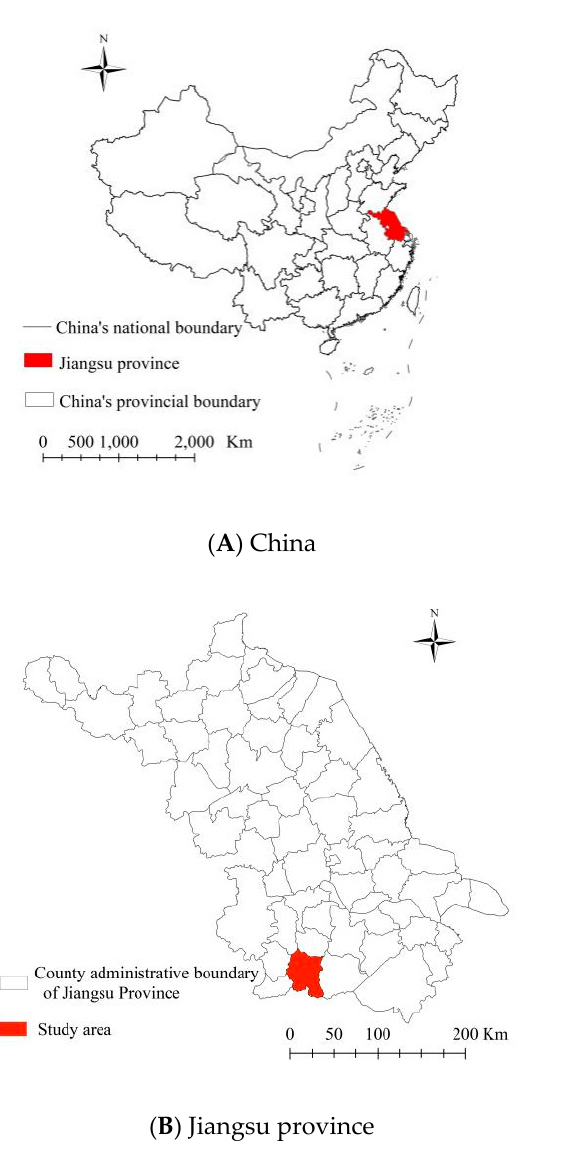
Figure 1. Location and land-use types of Liyang county, China, in 2019.